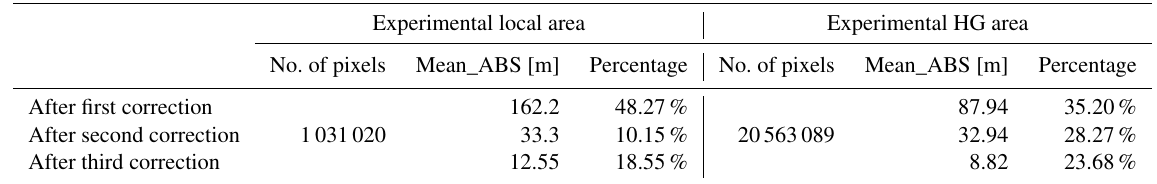
Figure 11. Elevation difference maps of the local area between the (a) original TDM DEM, (b) TDM DEM after the first multi-scale correction, (c) TDM DEM after the second multi-scale correction and (d) TDM DEM after the third multi-scale correction and the REMA mosaic. Elevation difference: TDM DEM minus REMA mosaic. Table 4. The mean absolute correction value and coverage percentage for the detected elevation